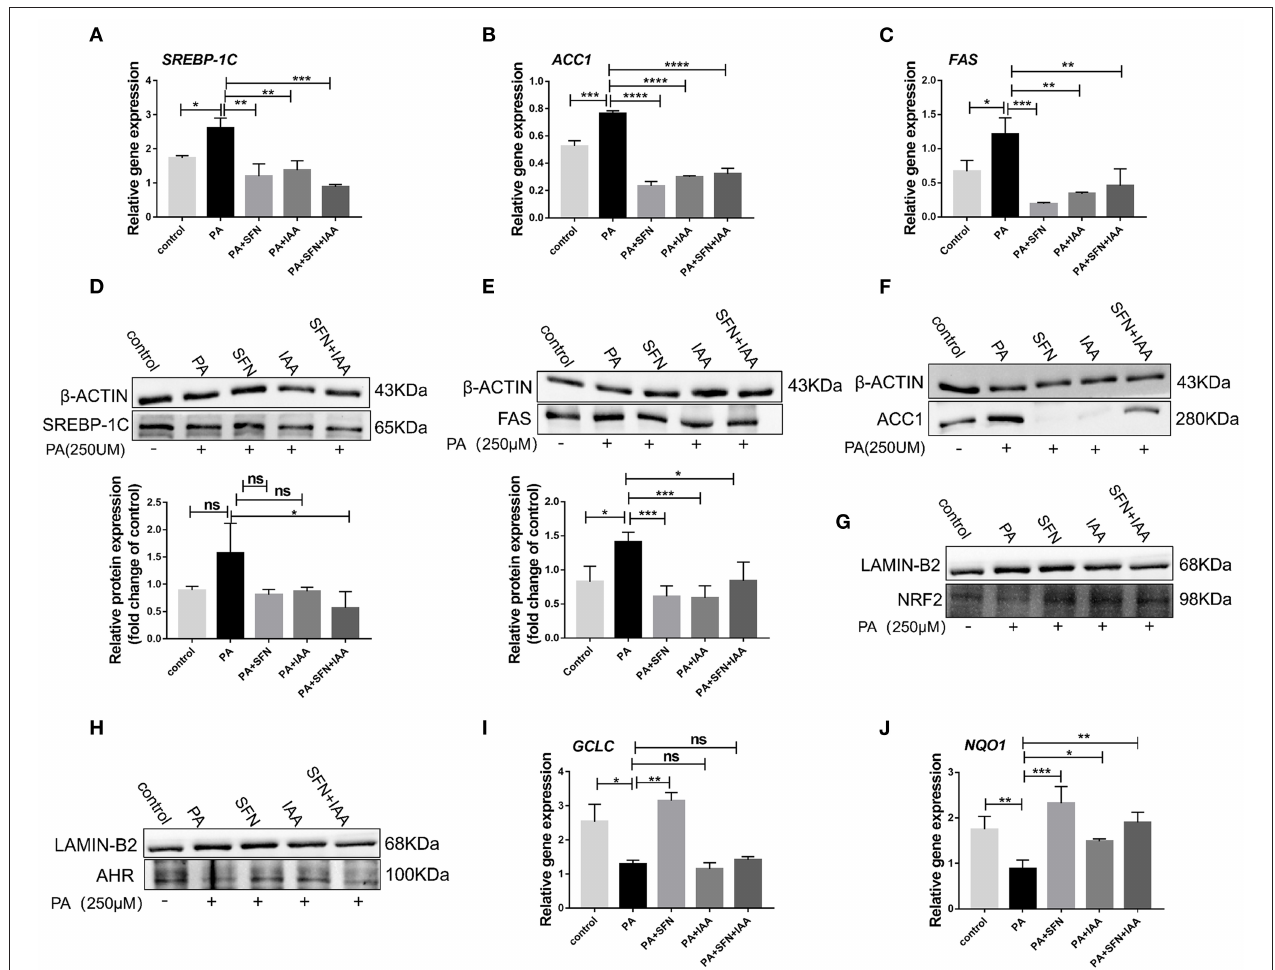
FIGURE 3 | SFN attenuates the expression of genes related to the de novo lipogenesis in HepG2 cells. (A–C) SFN decreased the mRNA expression of SREBP-1C , ACC1 , and FAS in HepG2 cells exposed to PA. (D–F) SFN decreased the protein expression of SREBP-1C, FAS, and ACC1 in HepG2 cells exposed to PA. (G,H) Immunoblots showing NRF2 and AHR content in the nuclear fractions. (I,J) Antioxidant stress relative gene expression in HepG2 cells. Quantitation of results of Western blot using Image J software. Data are presented as mean ± SD. ns means not significant, * P < 0.05, ** P < 0.01, *** P < 0.001, **** P < 0.0001 vs. HFD group.